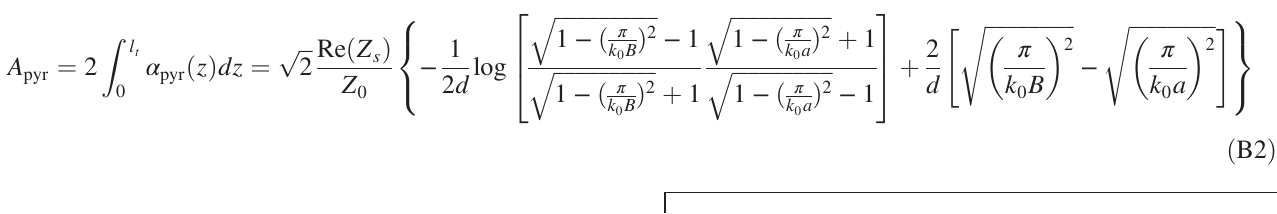
of electron cloud in the CERN Super Proton